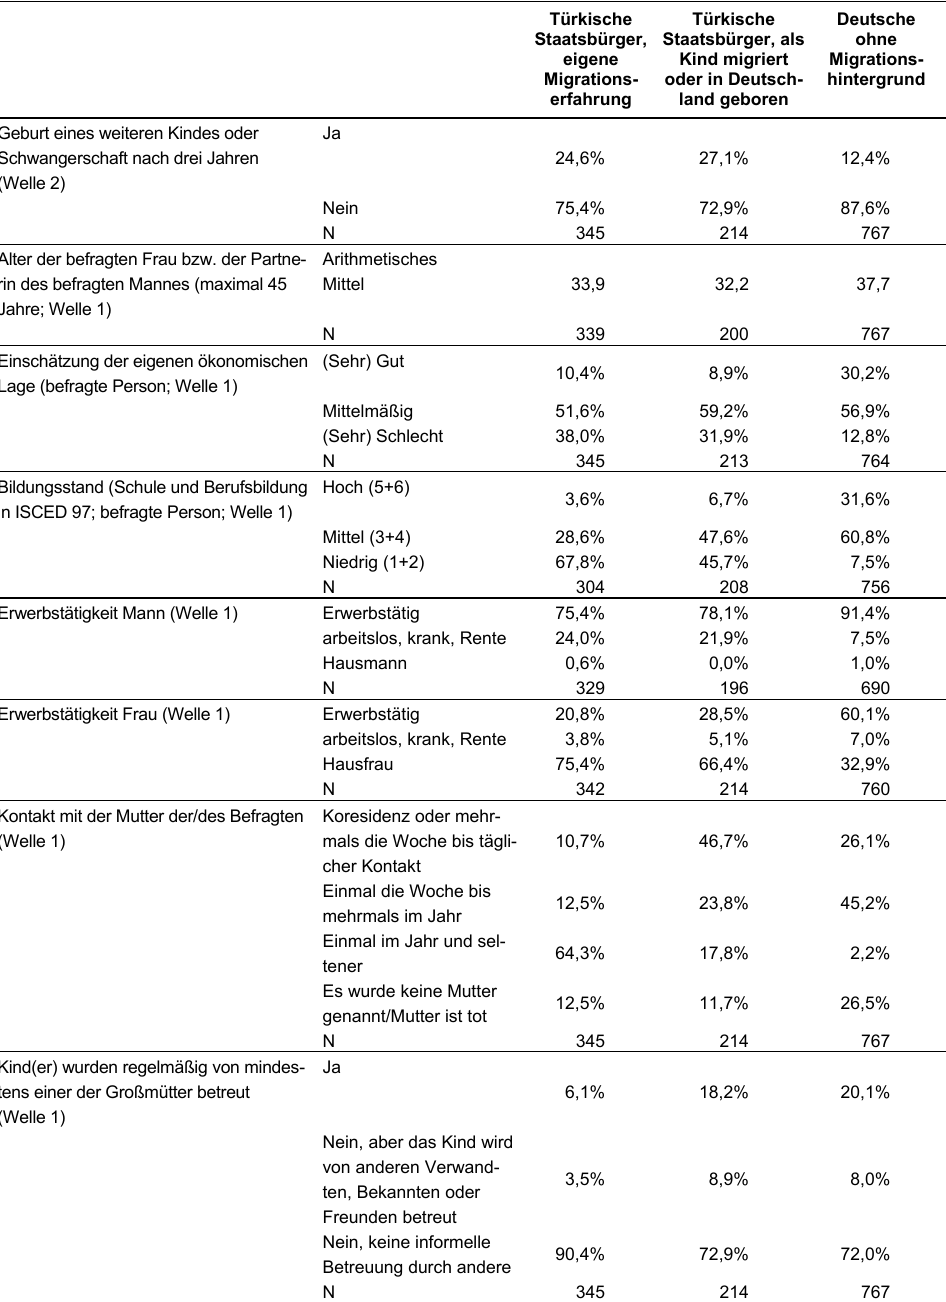
Tabelle 1 : Statistiken zu den verwendeten